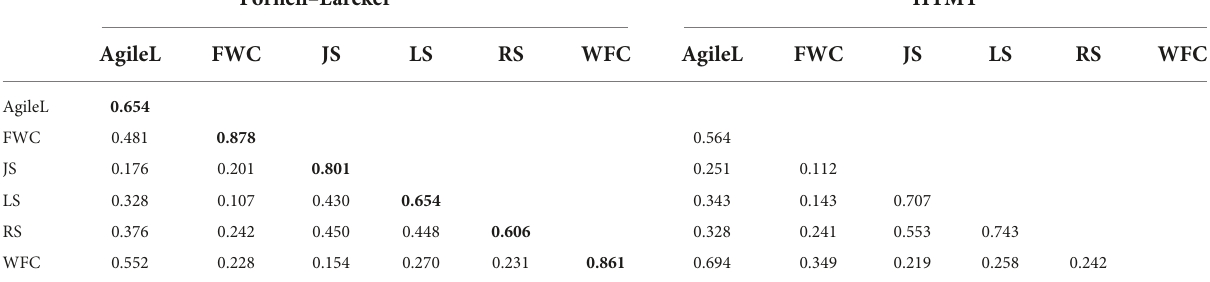
TABLE 4 Discriminant validity measures.